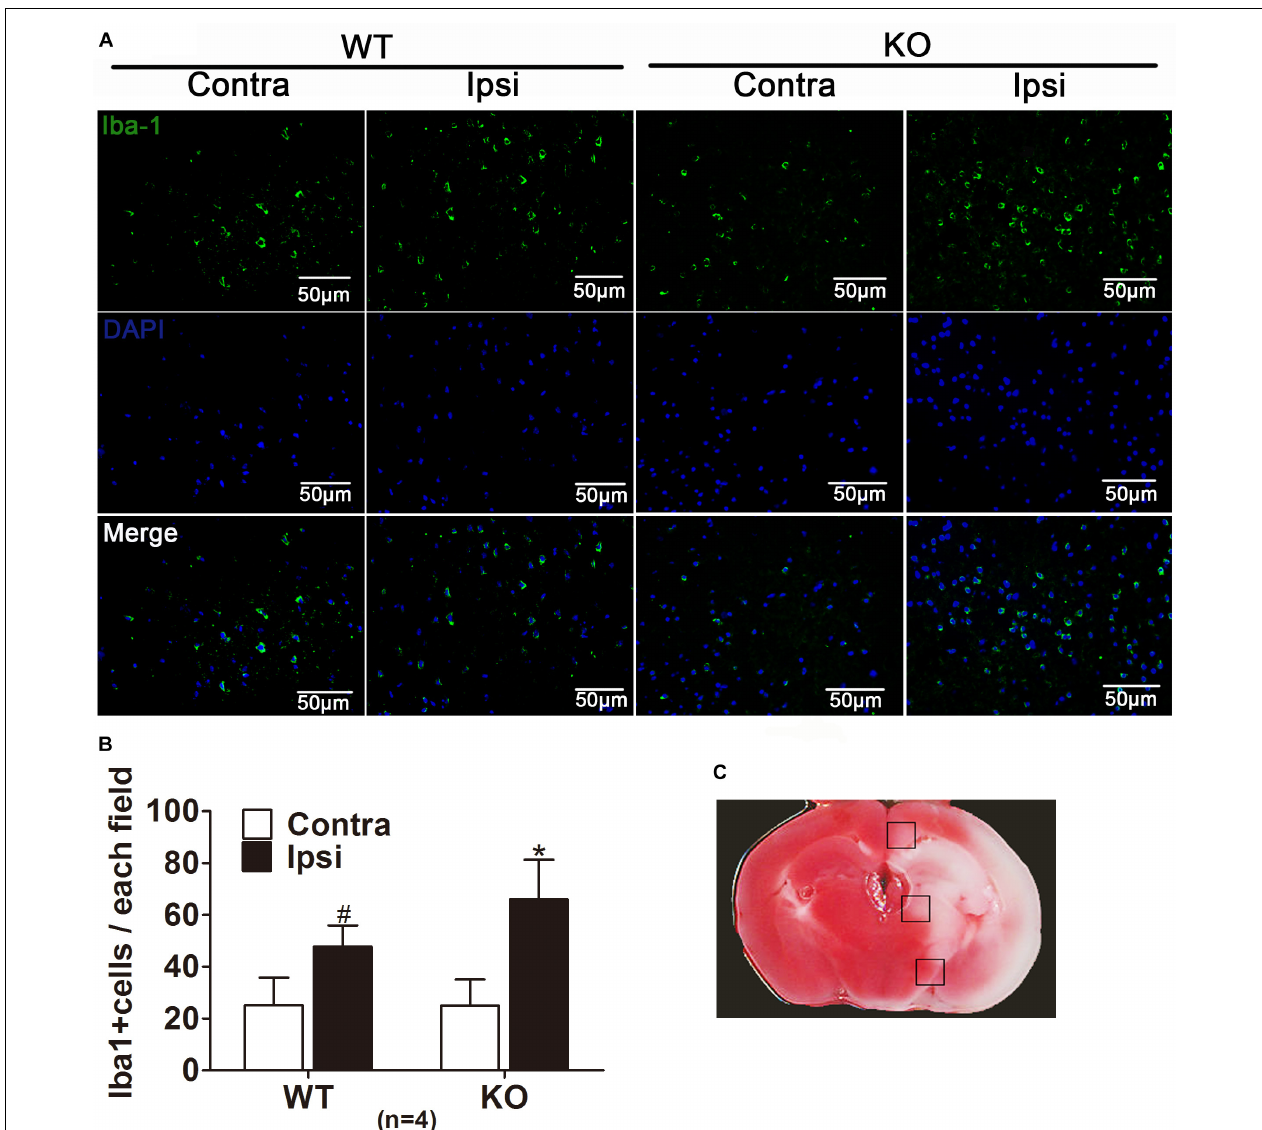
FIGURE 8 | IRAK-M deficiency is associated with the enhanced microglia in tMCAO mice. (A) Representative pictures of immunofluorescence staining with anti-Iba1 antibodies (green) in the peri-infarct cortex at 24 h after reperfusion. (B) The number of Iba1-positive cells were counted and shown in bar graph, Scale bar = 50 µ m. (C) TTC staining of ischemic brain manifested the location where the corresponding images were obtained. The brain region in black boxes indicates the areas where the typical Iba-1-positive cells were observed. The number of Iba1-positive cells was counted using ImageJ. n = 5 per group. ∗ P < 0.05 vs. WT group, # P < 0.05 vs. sham